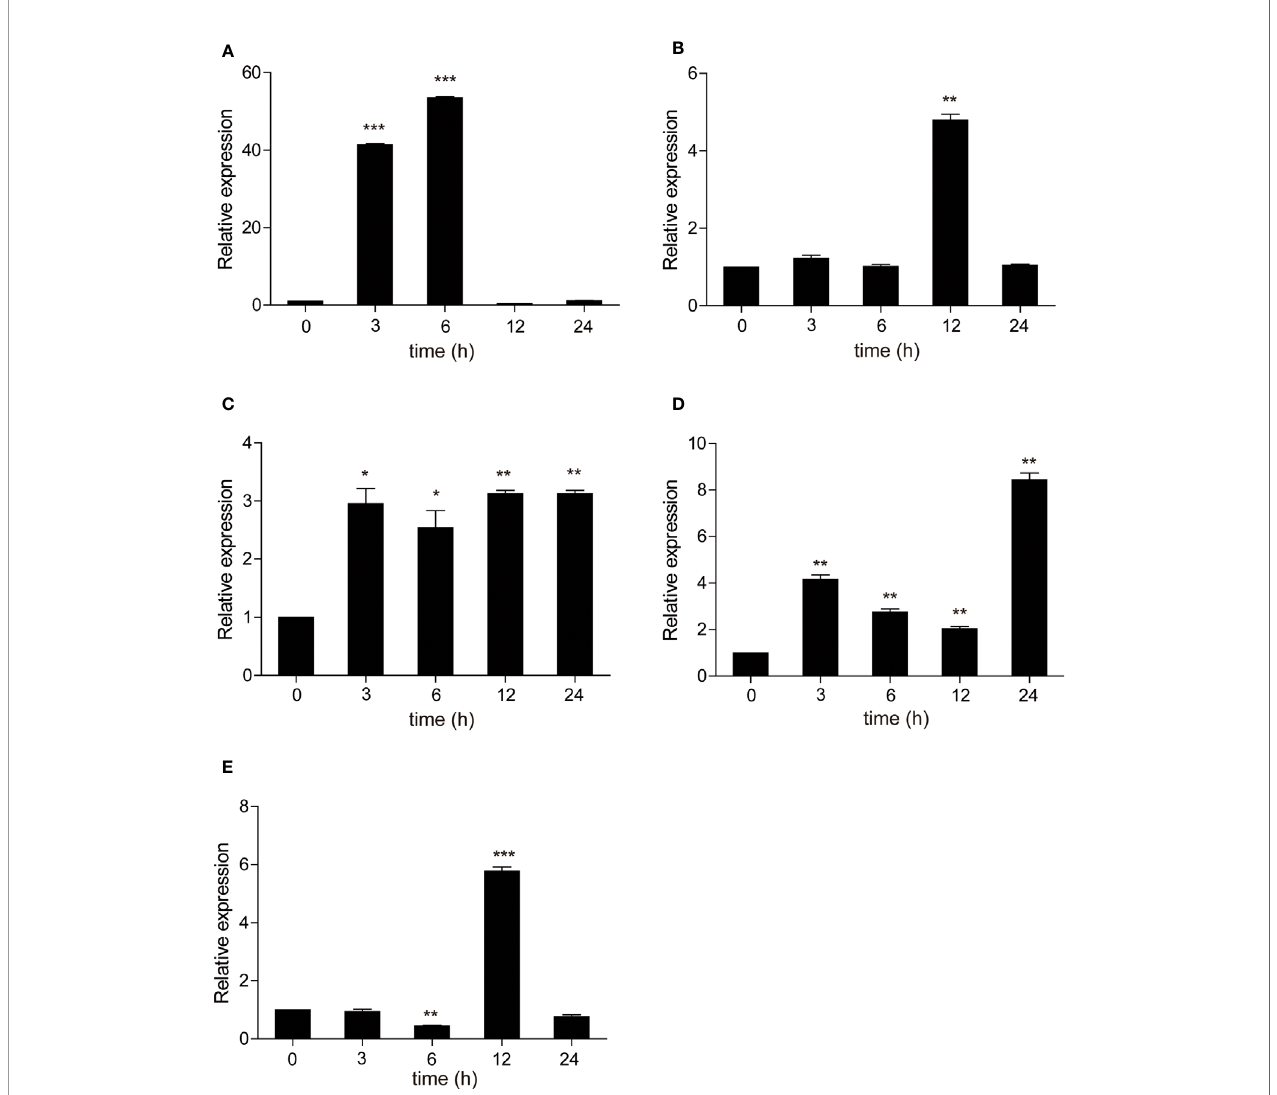
FIGURE 6 | The relative expression of carp TRIF in the PBLs after treatment with poly(I:C) (A) , LPS (B) , PGN (C) , fl agellin (D) , and Pam3CSK4 (E) at different time points. The results were calculated relative to the expression of 40S ribosomal protein s11. Data were presented as the fold change based on the control group (denoted by 0 h). Means ± SD (n = 3), * P < 0.05, ** P < 0.01, *** P <